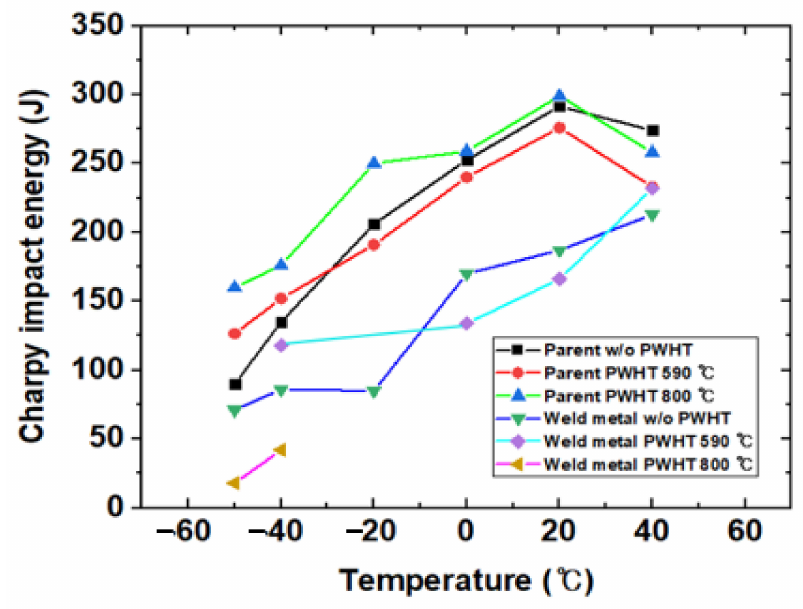
Figure 15. Charpy impact absorption